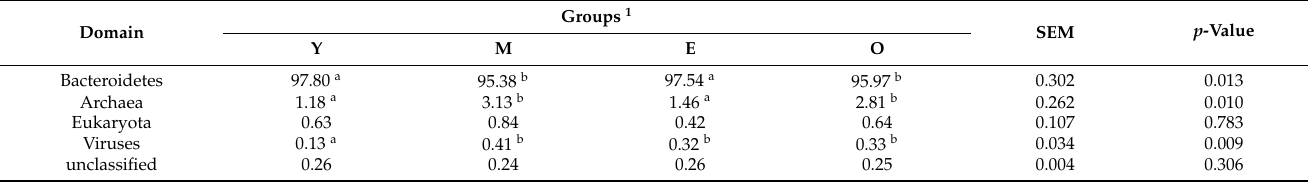
Table 1. Comparison of dairy buffalo rumen microbiota at the domain